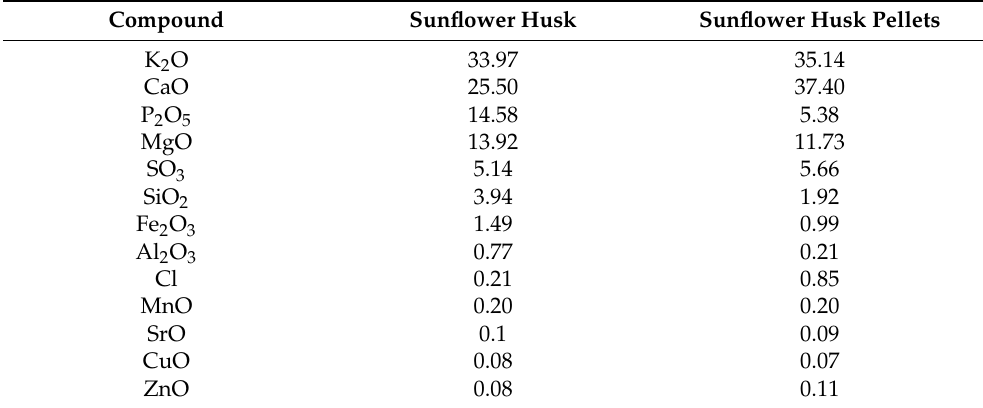
Table 3. Inorganic compounds identified in ash from the combustion of sunflower husk and sunflower